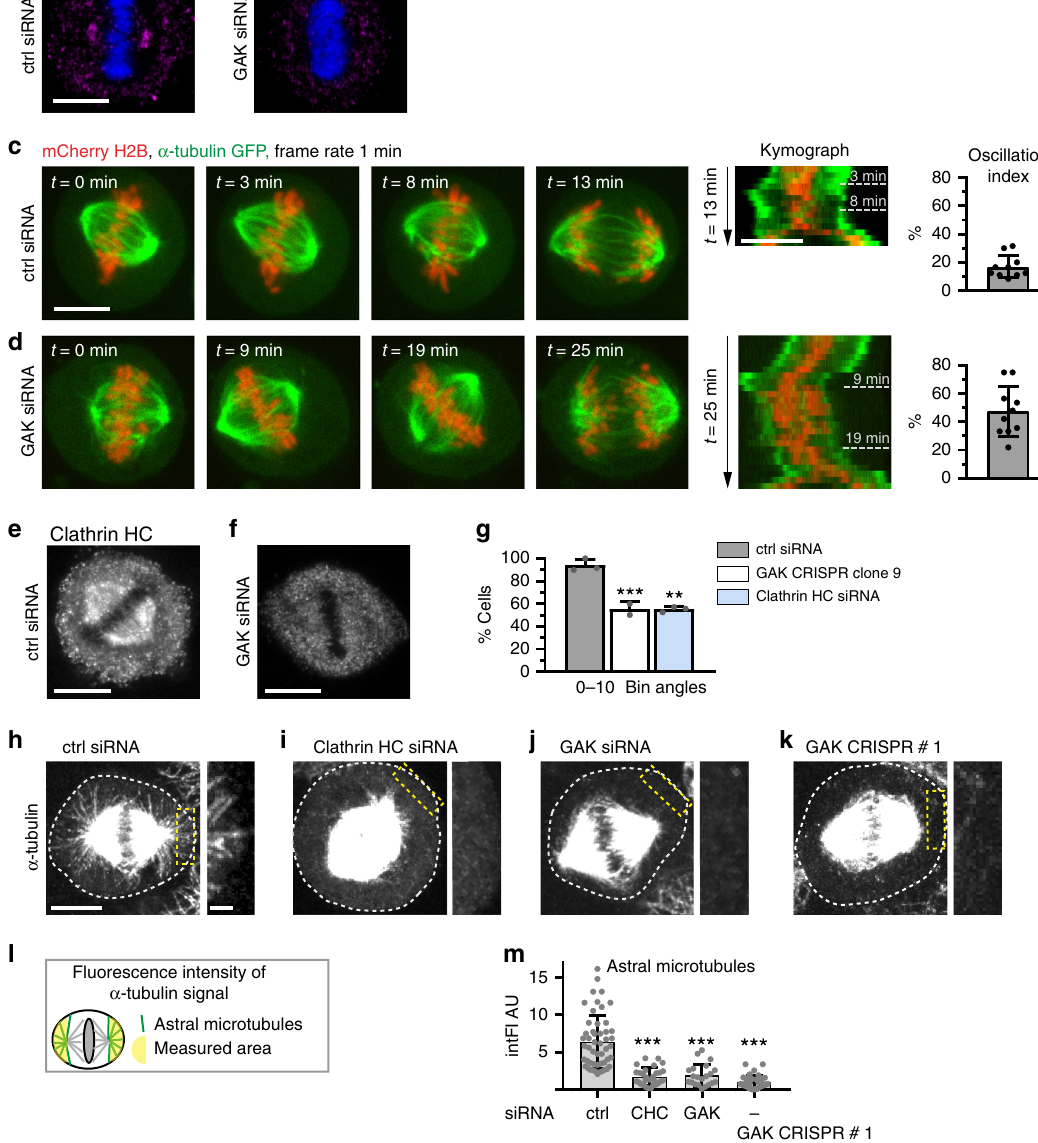
Fig. 5 Cyclin G-associated kinase (GAK) promotes the presence of astral microtubules during spindle positioning. a , b Immuno fl uorescence of metaphase HeLa cells treated as indicated and stained with GAK antibodies (red); DNA in blue. Scale bar: 10 µ m, throughout the fi gure, except where noted. c , d Stills (left) and corresponding kymographs (right, with positions of stills) from live imaging of HeLa cells expressing mCherry::H2B and GFP:: α -tubulin after ctrl, n = 10 cells ( c ) or GAK, n = 10 cells ( d ) small interfering RNA (siRNA) treatment, three independent experiments each, with corresponding mean oscillation indices values ± SD, p = 0.0003 comparing ctrl and GAK siRNA, unpaired two-tailed Student ’ s t test with Welch ’ s correction. e , f Immuno fl uorescence of metaphase HeLa cells treated as indicated and stained with Clathrin heavy chain antibodies (Clathrin HC). g Spindle positioning in cells grown on fi bronectin-coated coverslips and treated with ctrl ( n = 34 cells, three independent experiments) or Clathrin heavy chain siRNA ( n = 37 cells, three independent experiments); GAK CRISPR/Cas9 clone 9 is also shown ( n = 18 cells, two independent experiments). Shown are mean percentage of cells ±SD, aligning their mitotic spindles at 0 – 10° with respect to the surface; raw angle distributions were compared using Mann – Whitney U test, *** p = 0.0004: ctrl vs. GAK CRISPR, ** p = 0.0066: ctrl vs. Clathrin siRNA. Note that only cells with robust central spindle microtubules were analyzed to avoid potential phenotypes stemming from spindle assembly defects. h – k Immuno fl uorescence of metaphase HeLa cells treated with indicated siRNAs and stained with α -tubulin antibodies. Imaging was conducted so as to enable visualization of astral microtubules, if present. Insets show magni fi cations of indicated cortical regions; dashed lines: cell boundaries. Scale bar in inset: 2 µ m. l , m : Measurements of astral microtubule α -tubulin fl uorescence corresponding to ( h – k ) in the area indicated in l . Shown are averages of two poles per cell in z-projections of relevant optical planes (in arbitrary units, AU, ±SD). The number of cells analyzed from two independent experiments each were: ctrl siRNA: 52, Clathrin heavy chain siRNA (CHC): 29, GAK siRNA: 21, GAK CRISPR cell line: 37, ctrl vs. CHC: *** p = 3 × 10 − 12 , ctrl vs. GAK: *** p = 1 × 10 – 10, ctrl vs. GAK CRISPR # 2: *** p = 8 × 10 − 15 , unpaired two-tailed Student ’ s t test with Welch